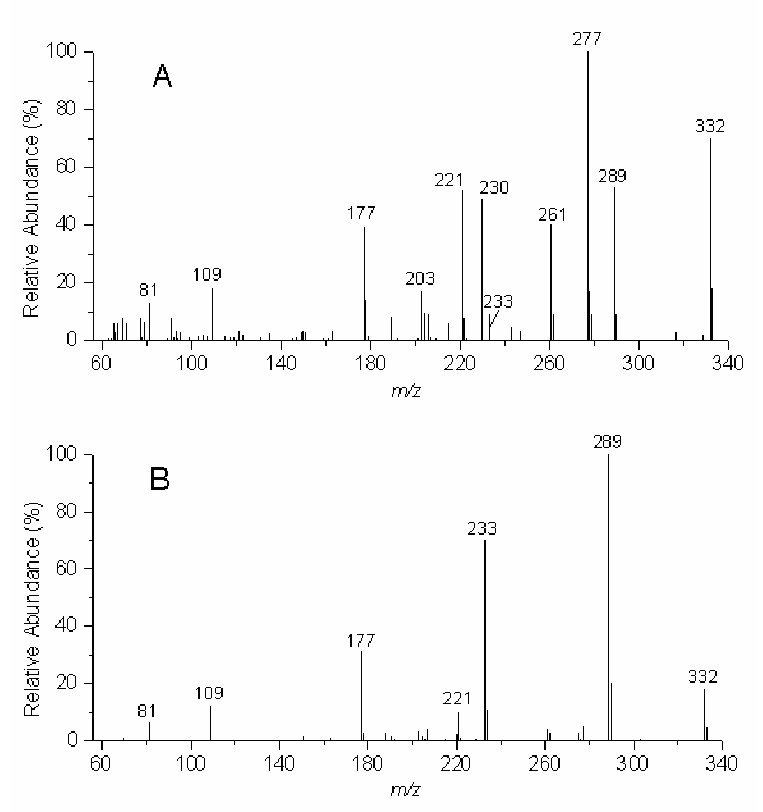
Figure 3 . EIMS (70 eV) of the "angular" benzodipyran 2 (A, upper panel) and the "linear" benzodipyran 3 (B, lower